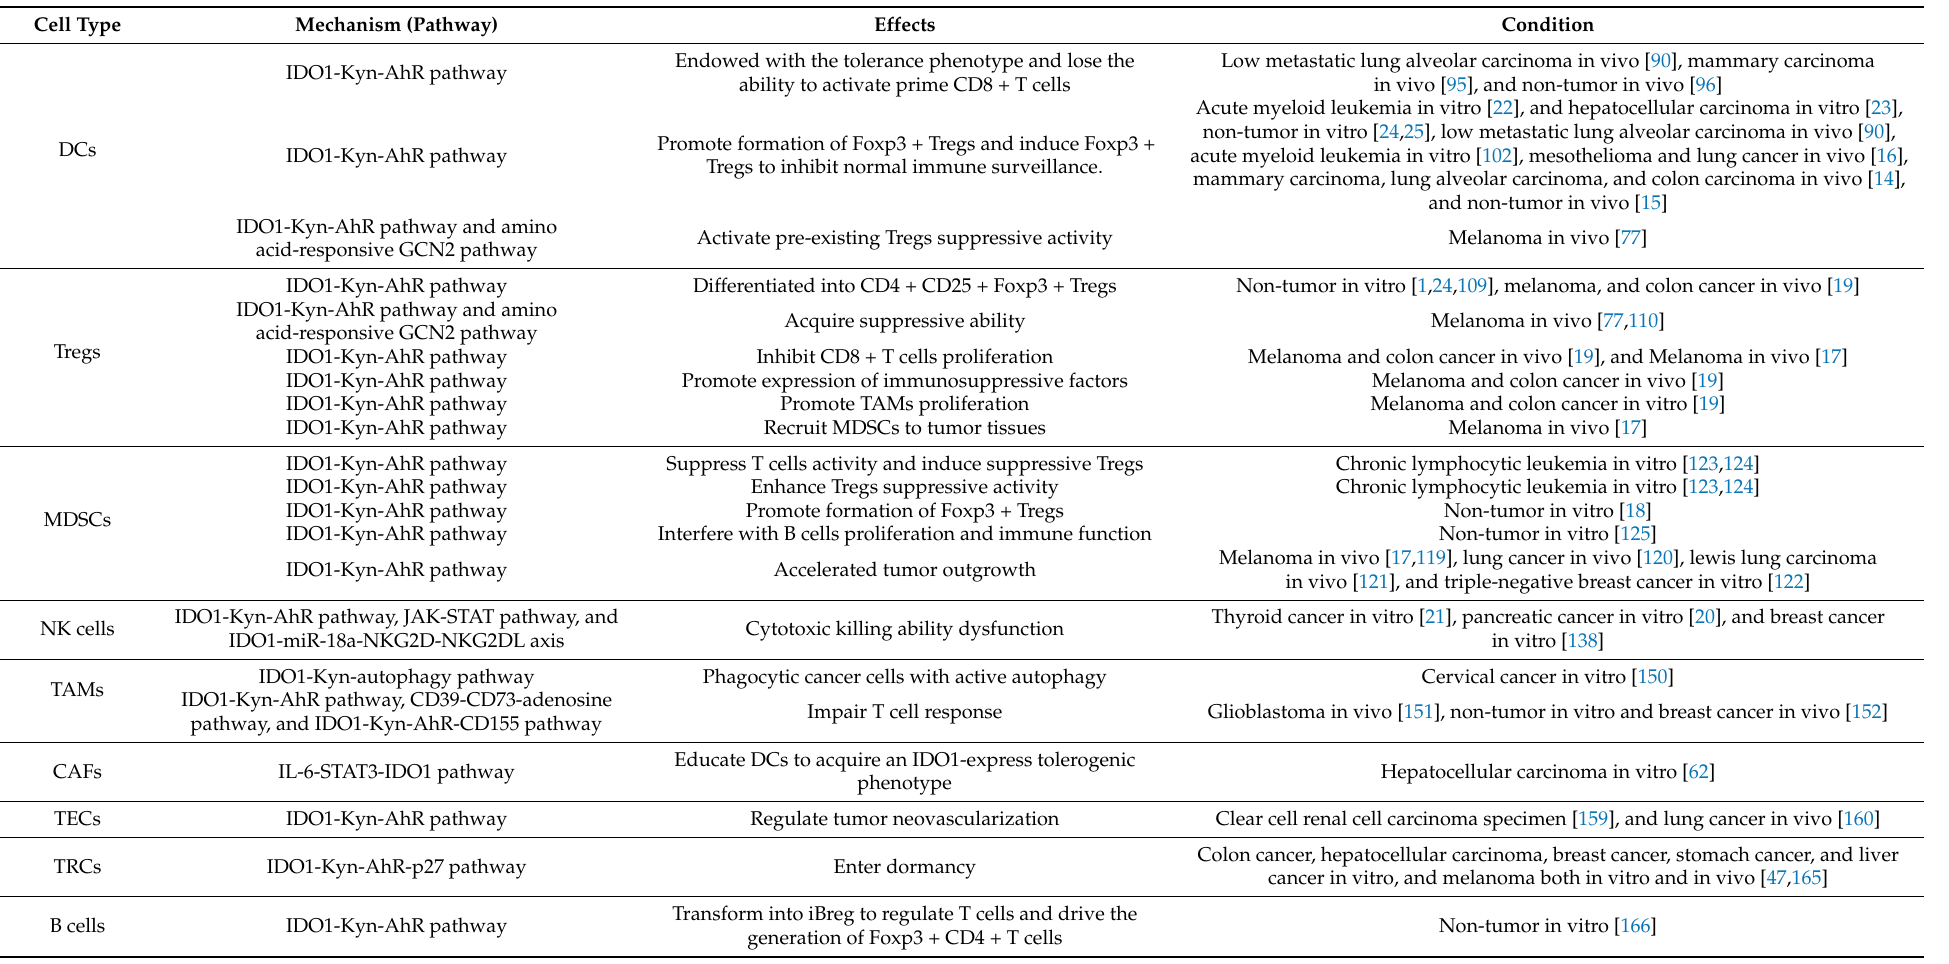
Table 1. IDO1 affects immune-related cells under different